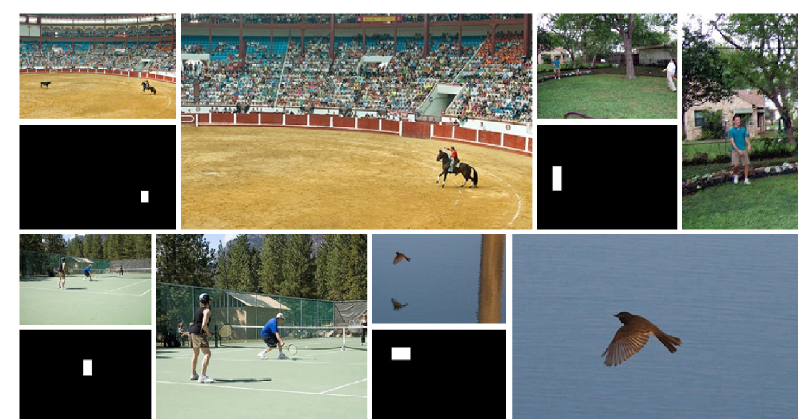
Fig. 13 Failures of SAC-Net on the SACD test set.